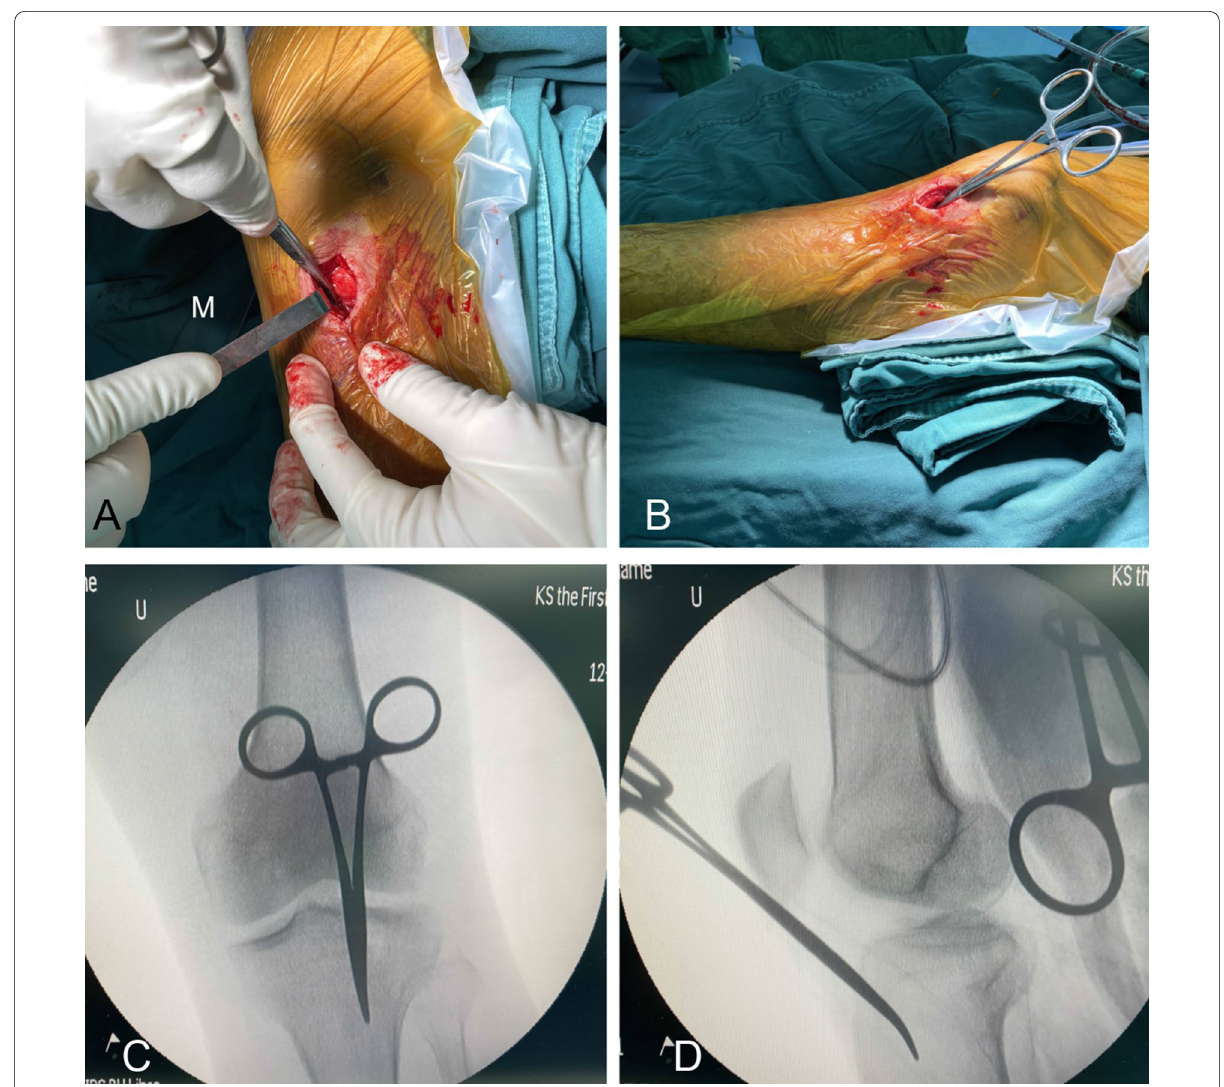
Fig. 3 The entry point of the SEIP technique. Intraoperative photographs A and B show that the patellar tendon is pulled medially to visualize the tibial tuberosity slope. Hemostatic forceps are employed to position the tibial entry point. An ideal entry point was observed on the AP fluoroscopic view C as being located just medial to the lateral tibial spine, and it aligns with the tibial shaft. A lateral view D of the entry point located at the tibial tuberosity slope, approximately 10 mm distal to the anterior articular margin. SEIP semi‑extended infrapatellar, M medial, AP